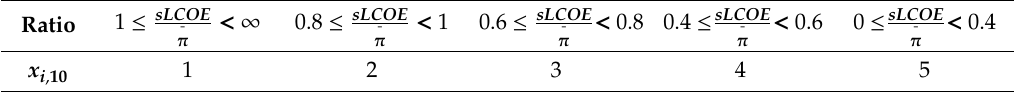
Table 10. Performance values x i ,10 for 10th